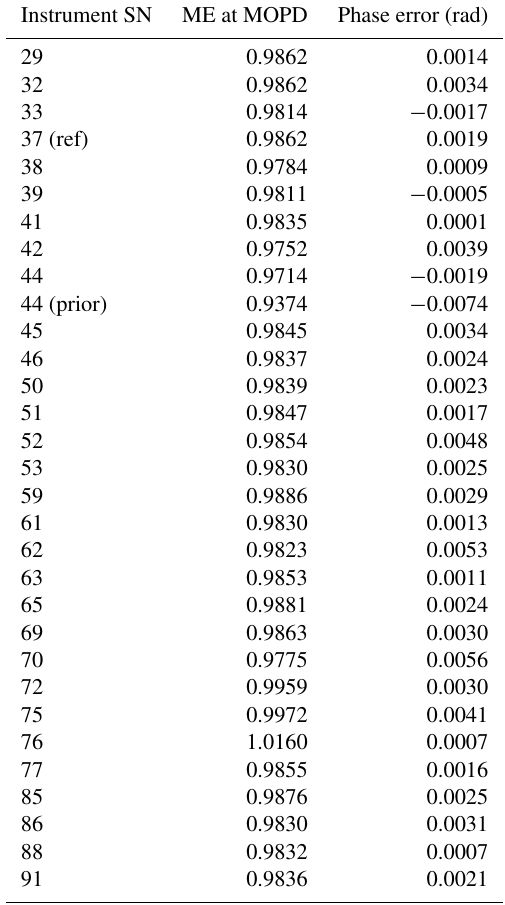
Table 5. Summary of the modulation efficiencies at MOPD and phase errors for all EM27/SUN calibrated in Karlsruhe. “ref” de- notes the reference EM27/SUN and “prior” denotes an ILS mea- surement with instrument SN44 prior to calibration at